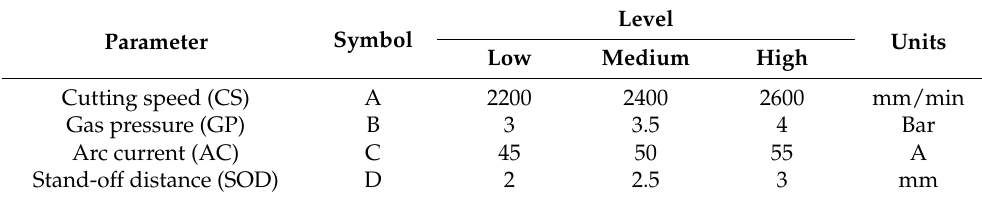
Table 1. Selected PAC parameters and their levels.